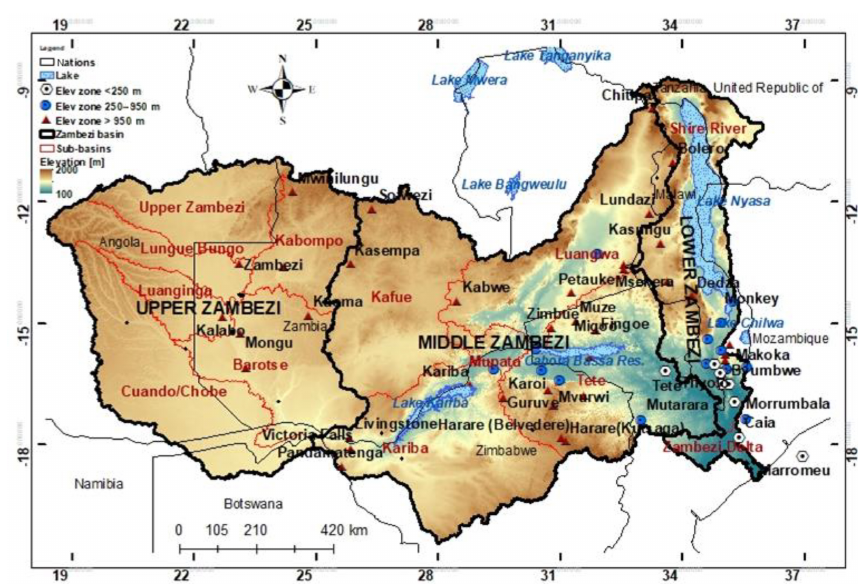
Figure 1. Zambezi River basin from Africa with sub-basins, major lakes, elevation, and locations and names of the 60 rain-gauging stations (in each respective elevation zone) used in this study.